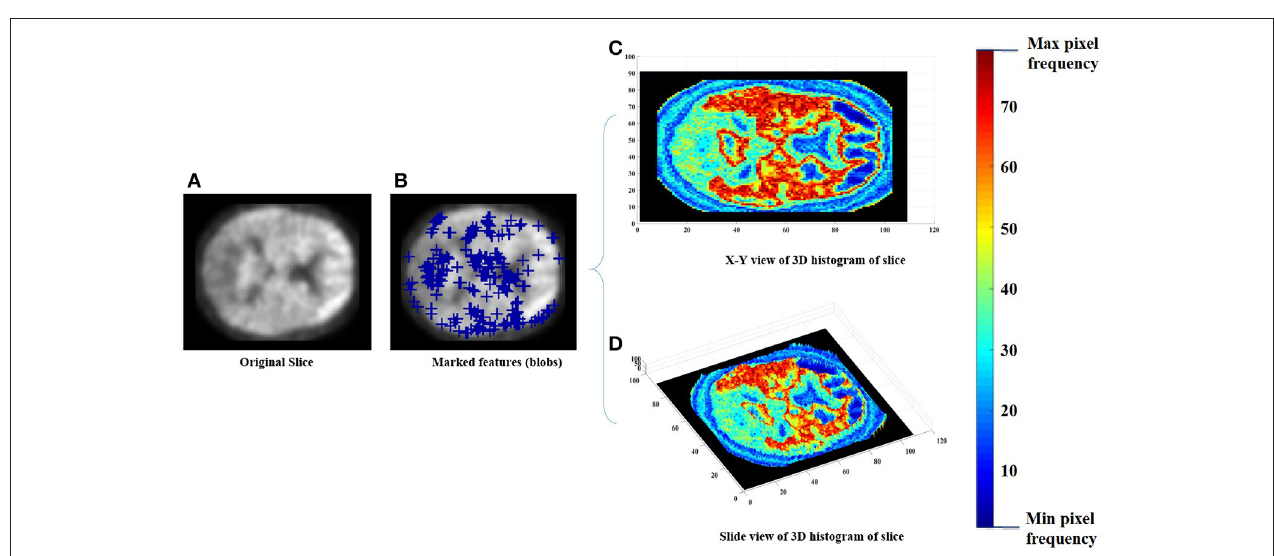
FIGURE 2 | An example of the feature extraction step, (A) the original slice, (B) the obtained features (blue pluses), (C,D) a 3D histogram representation of the slice to indicate the targeted local maxima/minima